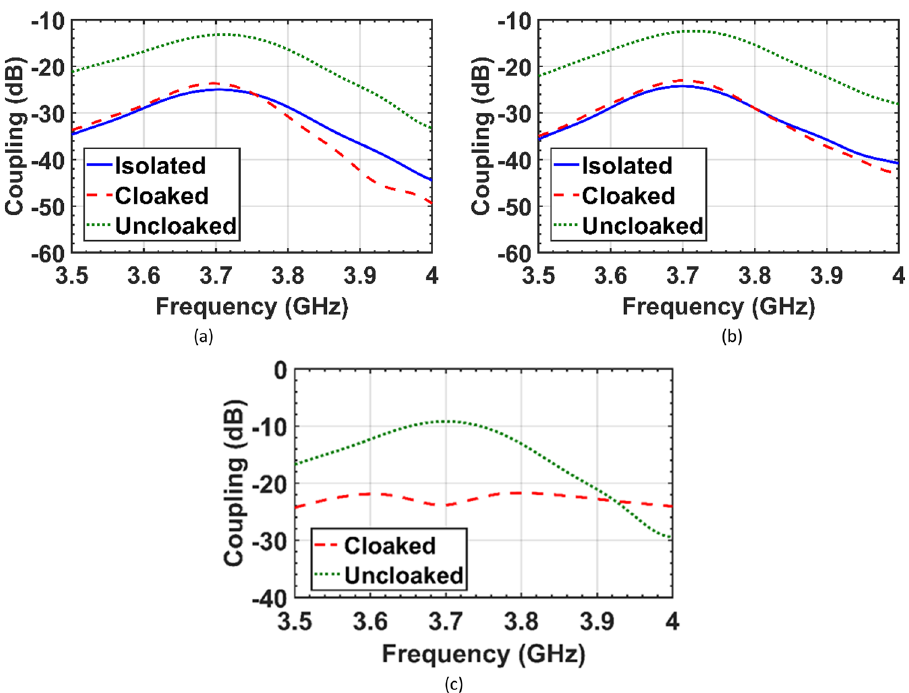
Figure 13. Simulated mutual coupling between the central elements of the two arrays in the isolated, uncloaked and cloaked configurations. (a) coupling between the elements of the array I, S 23 , (b) coupling between the elements of array II, S 78 , ( c ) cross-coupling between the adjacent elements of the two interleaved arrays, S 38 .